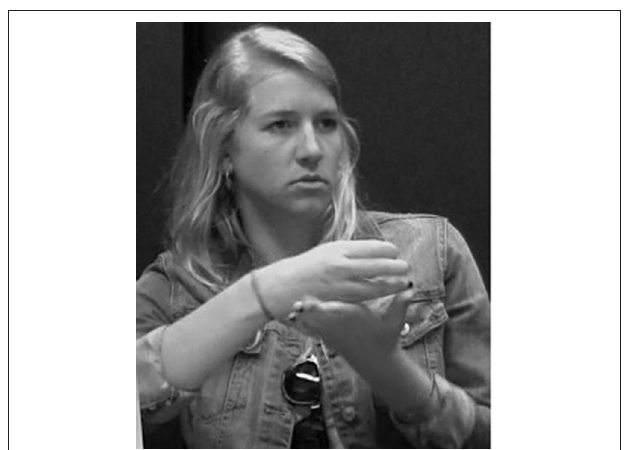
FIGURE 2 | ASL Sign